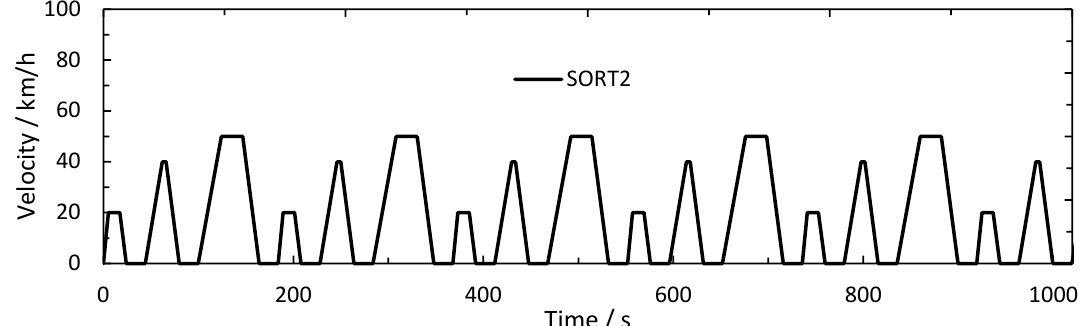
Figure 1. Velocity profile for repeated sequence of Standardized On-Road Test Cycle 2 (SORT2).